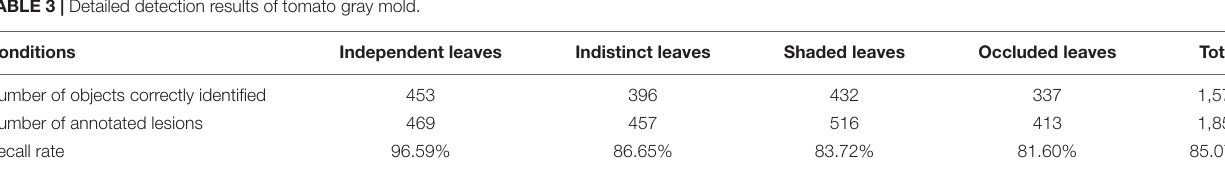
TABLE 3 | Detailed detection results of tomato gray